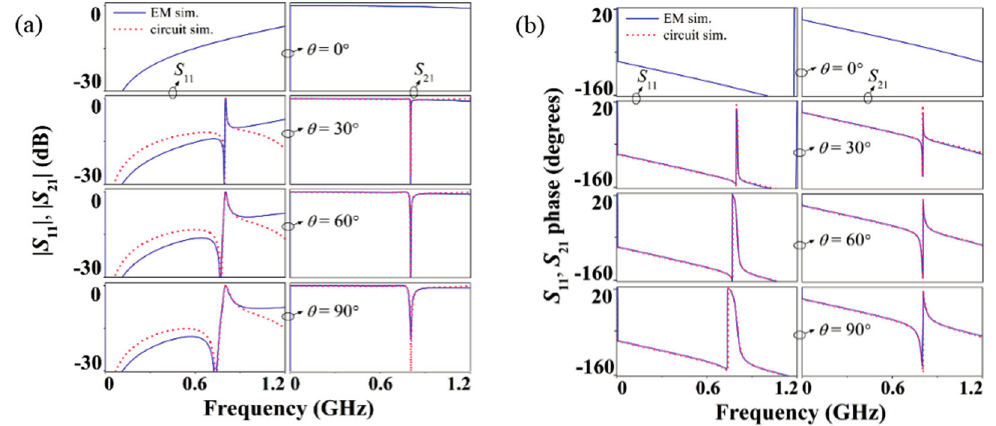
Figure 12. ( a ) Magnitude and ( b ) phase of the reflection and transmission coefficients given